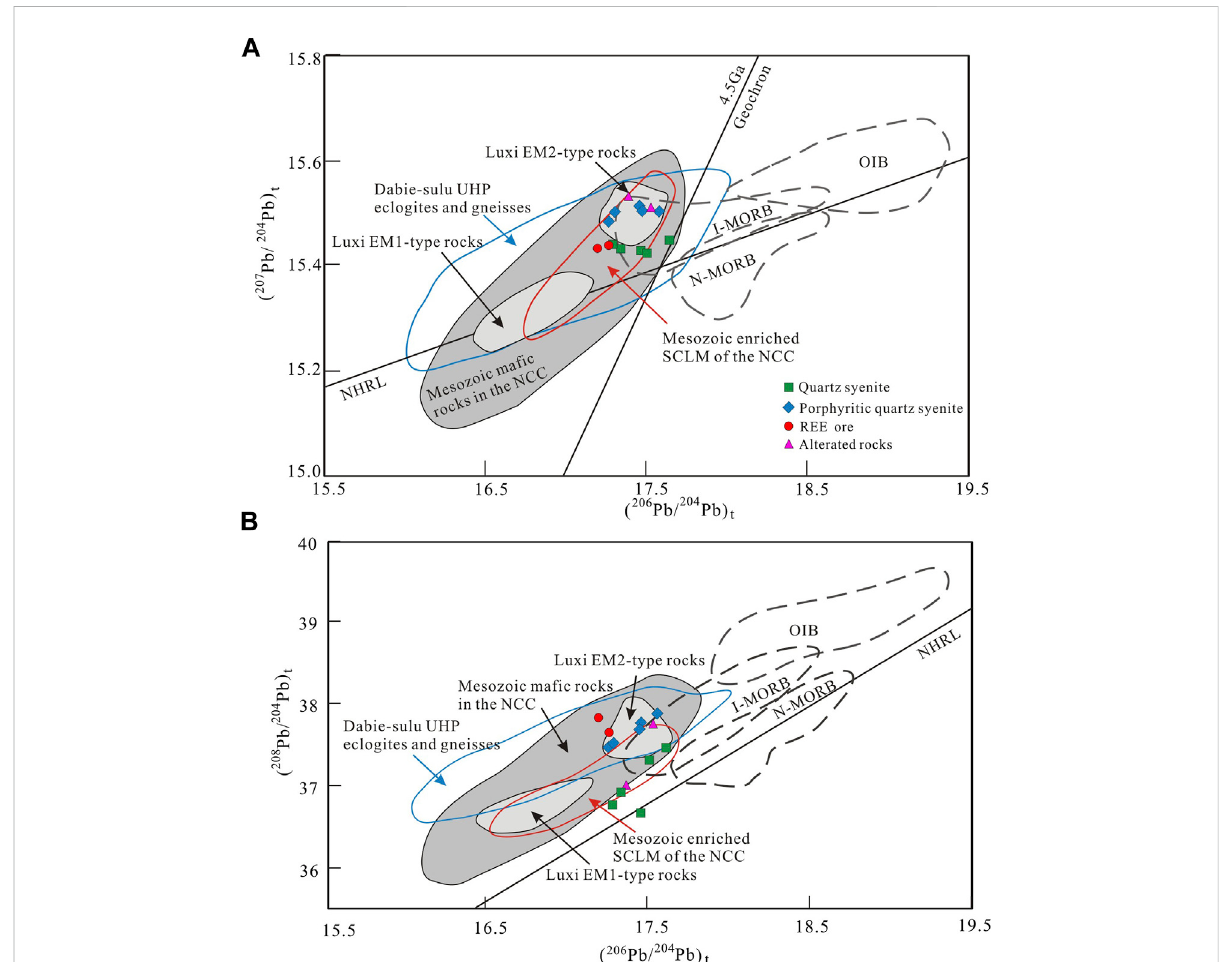
FIGURE 7 Diagrams of 207 Pb/ 204 Pb versus 206 Pb/ 204 Pb (A) and 208 Pb/ 204 Pb versus 206 Pb/ 204 Pb (B) for the Chishan and Longbaoshan complexes. Data are also plotted for Mesozoic-enriched SCLM of the NCC (from Dai et al., 2016), Dabie-Sulu UHP eclogites and gneisses (from Yang K. F. et al.,